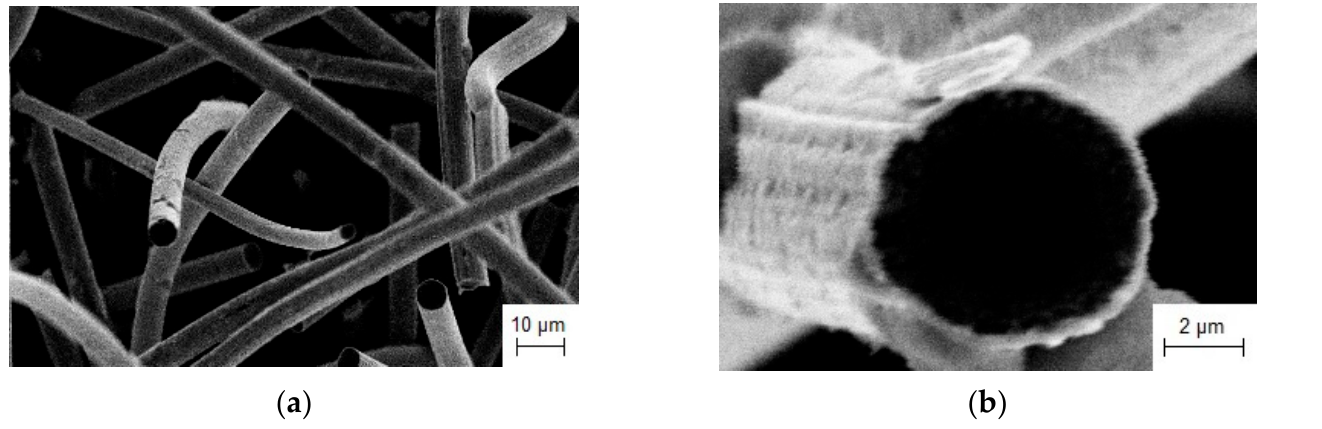
Figure 10. Micrographs of the tantalum carbide-carbon fiber composite at different scale. ( a )—Overall view and ( b )—cross-section of a single fiber. Synthesis conditions: CT in NaCl-KCl-K 2 TaF 7 (30 wt.%)–Ta melt at 1123 K for 24 h.